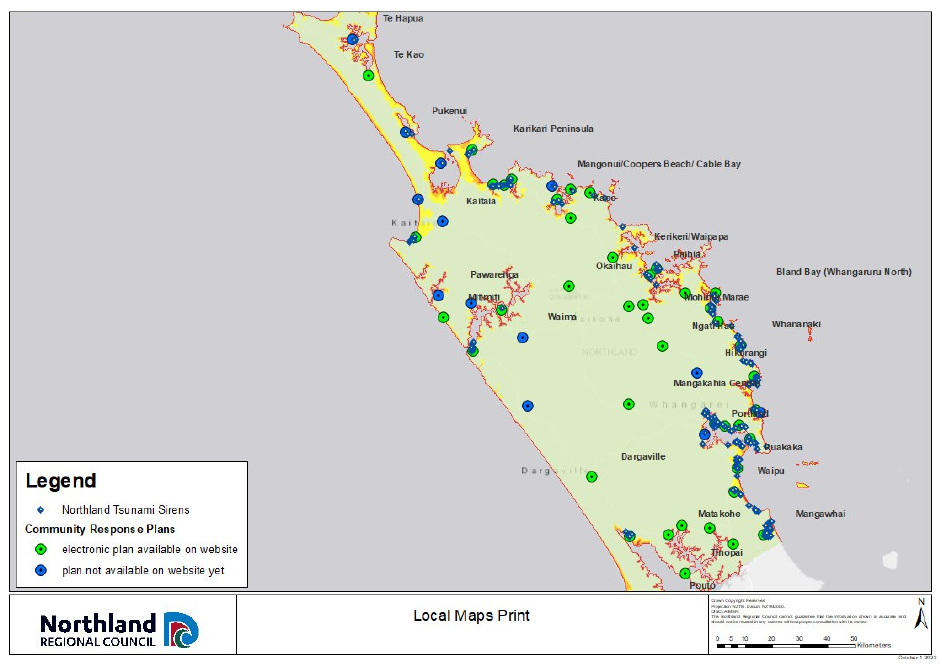
Figure 3. Mapping the areas have CRP available online (green) and not yet available online (blue)